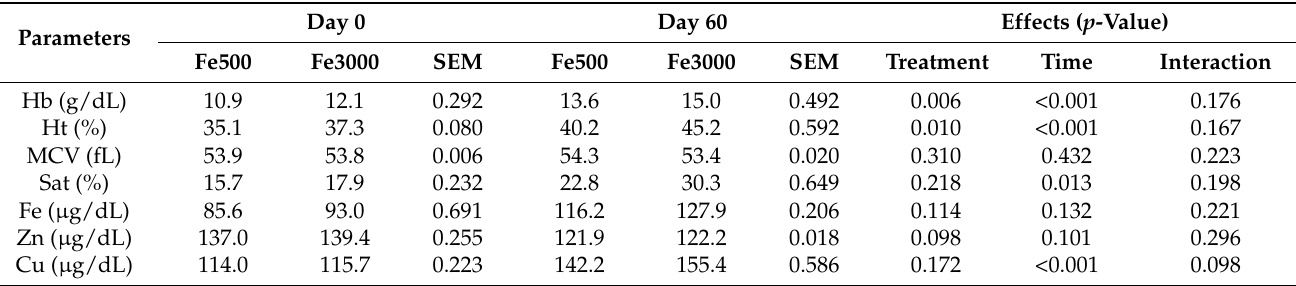
Table 3. Evolution of hematological parameters and serum concentration of iron (Fe), copper (Cu), and zinc (Zn) of pigs before (day 0) and after iron supplementation (day